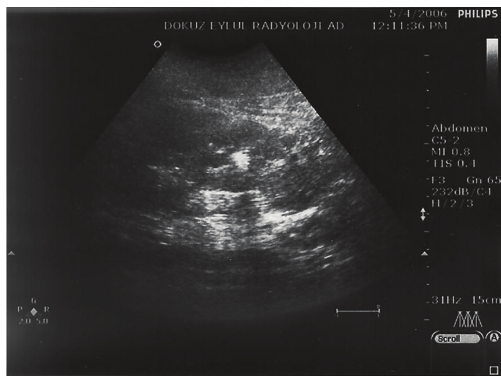
Figure 1: Cysts and calculi appear on USG.